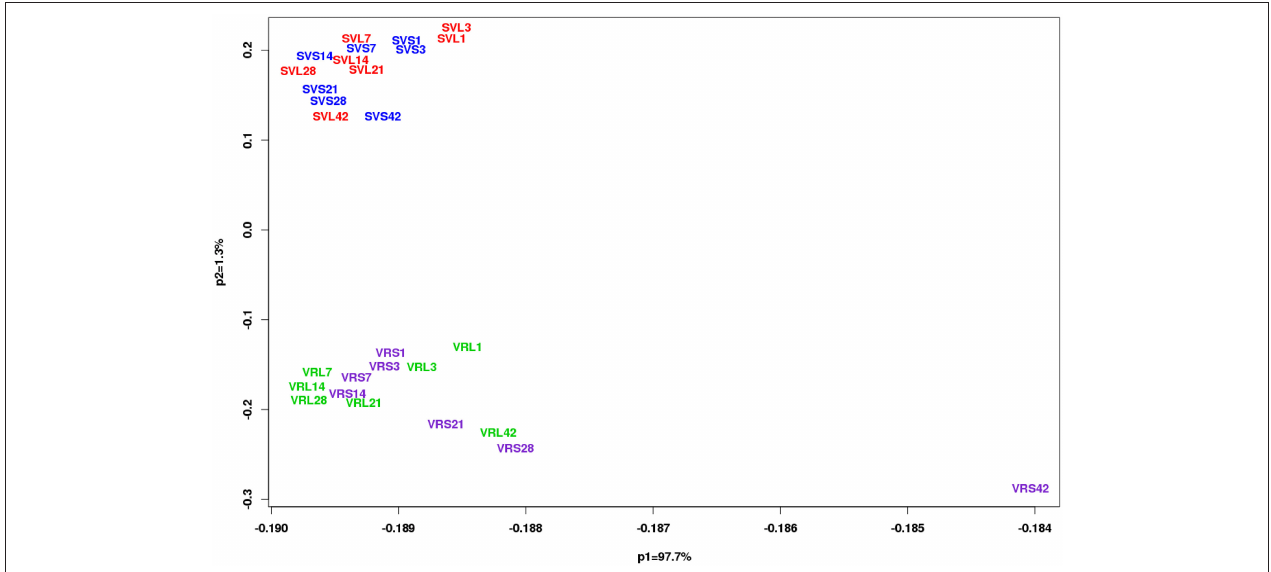
FIGURE 2 | Principal component analysis (PCA) of genotype ( V. riparia and Seyval) and time (D01, D03, D07, D14, D21, D28, and D42 of treatment). Analysis was conducted on the quality-controlled data (13,587 probesets in 6 replicates) using a correlation matrix. Photoperiod treatments are color coded for each genotype. V. riparia [LD, green (VRL1, 3, 7, 14, 21, 28, and 42); SD, purple (VRS1, 3, 7, 14, 21, 28, and 42)] and Seyval [LD, red (SVL1, 3, 7, 14, 21, 28, and 42) and SD, blue (SVS1, 3, 7, 14, 21, 28, and 42)].